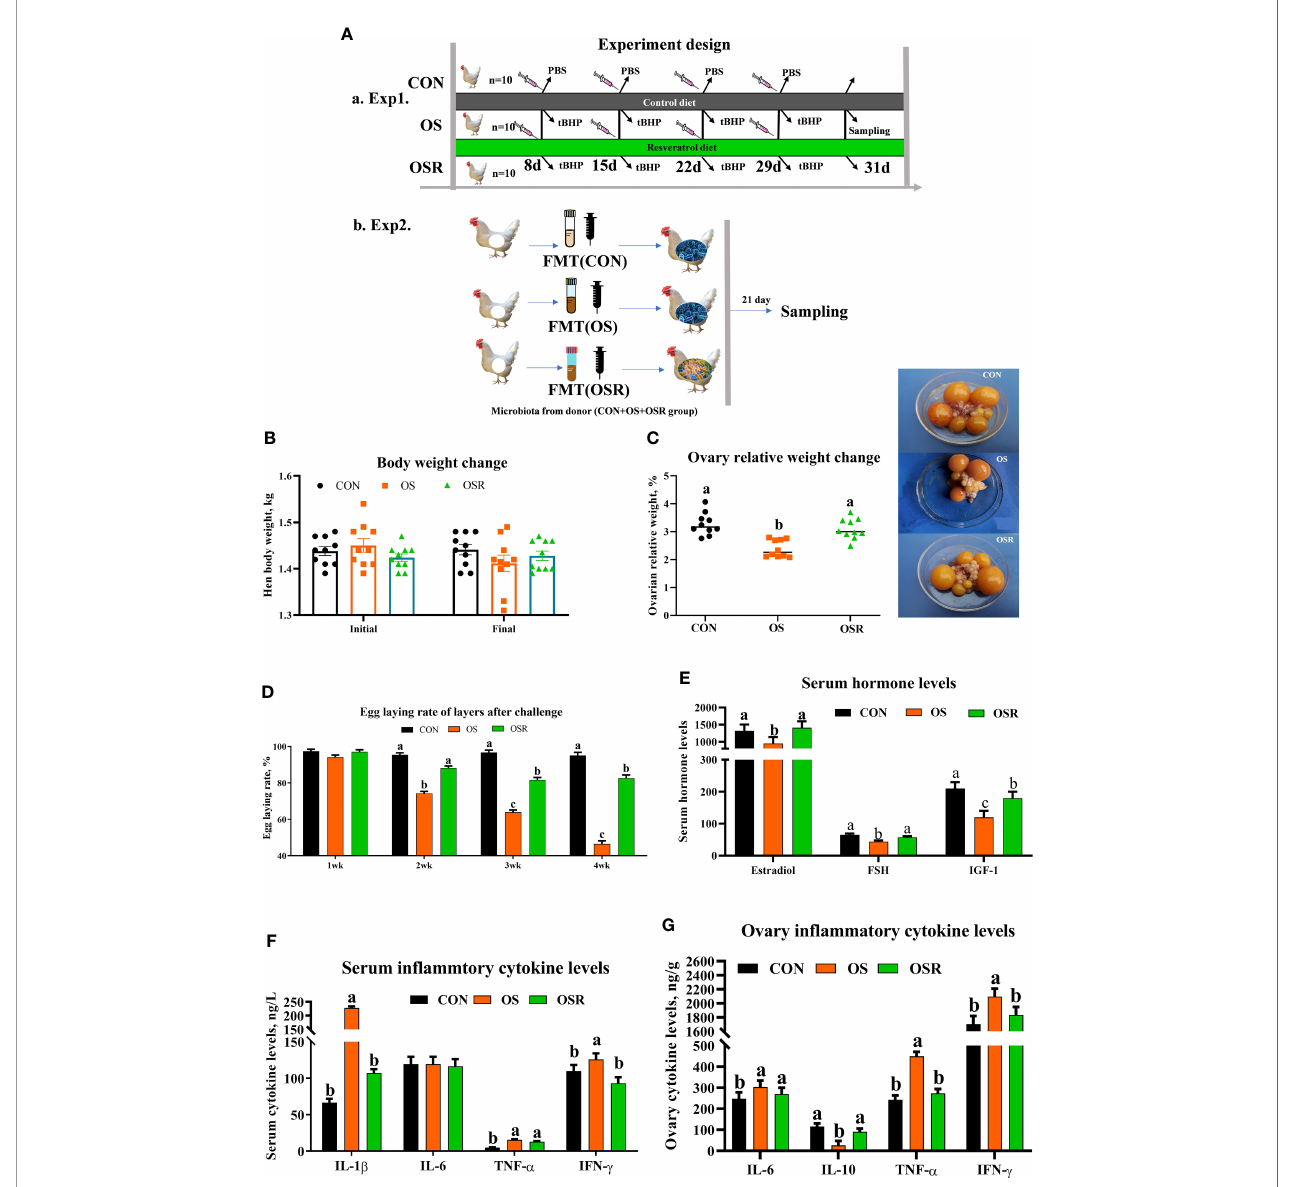
FIGURE 1 | Dietary resveratrol supplementation alleviated the oxidative stress (by tBHP) induced depression in egg-laying rates, reproductive hormones, and cytokine levels. Data are means ± SEM represented by vertical bars or plot individual values ± SEM. (A) Schematic illustration of the experimental design. a, in experiment 1, layers were fed the same basal diet for 24 days and with the tBHP (OS) or PBS (CON) injection at 9 AM on d 8, 15, and 21. The OSR group diet was supplemented with 600 mg/kg resveratrol added in CON treatment. b, in experiment 2, the microbiota-depleted layers were fed CON diet and received FMT from donor mice (n= 10/group) that were fed resveratrol. (B) Body weight change. (C) Ovary index. (D) Egg-laying rate after challenge. (F) Serum hormone levels. (G) Serum cytokine levels. (D) Ovary cytokine levels. CON, control; OS, oxidative stress (injection of 800 m mol/kg BW of tBHP); OSR, CON + 600 mg/kg resveratrol; FSH, follicle-stimulating hormone; IGF-1; insulin-like growth factor-1, IL-1 b = interleukin-1 b ; IL-6, interleukin-1, IL-10, interleukin-10; TNF- a , tumor necrosis factor alpha; IFN- g , Interferon- g . Statistical signi fi cance was evaluated by Tukey ’ s Test. p <